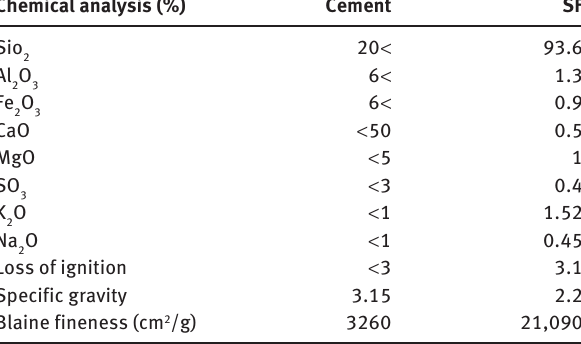
Table 1 Chemical composition and physical properties of cement and SF.